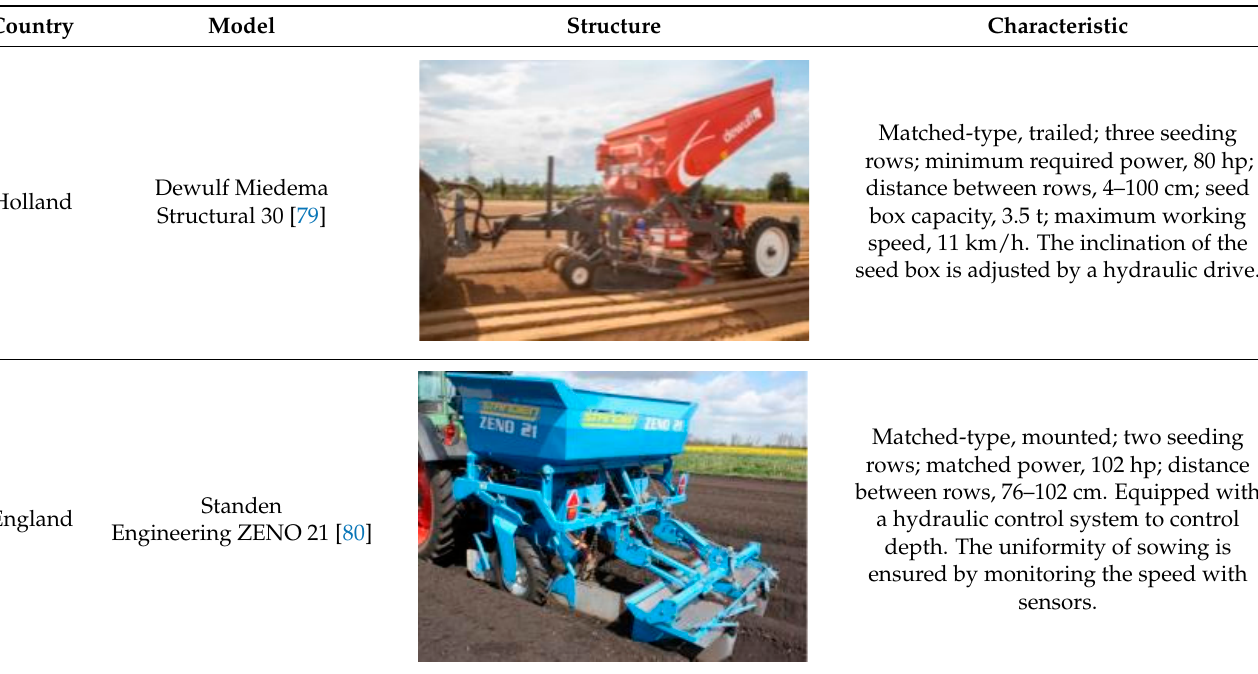
Figure 16. Harriston Pick Planter. Reprinted with permission from ref. [48] Copyright 2019 Harris- ton Industries. 3.2.5. Pickup-Finger-Type Potato Planter This type of planter has poor performance stability and operation quality. The curve of the finger clip guide rail of this structure is fixed, resulting in the fixed opening stroke of the finger clip. However, the overall dimensions of potatoes are different, so there is a high rate of reseeding and missed seeding, and it is impossible to operate at high speed. At present, this principle has been applied in the seed metering device with small particle size and regular shape for corn and soybean, while in the potato planter, only a few man- ufacturers, such as Lockwood and Harriston, have provided models that can be applied practically. The Lockwood 506 series potato planter is presented in Figure 17, the Harris- ton Clamp planter [83] is presented in Figure 18. Figure 17. Lockwood 506 series potato planter. Reprinted with permission from ref. [48] Copyright 2018 Lockwood Industries.